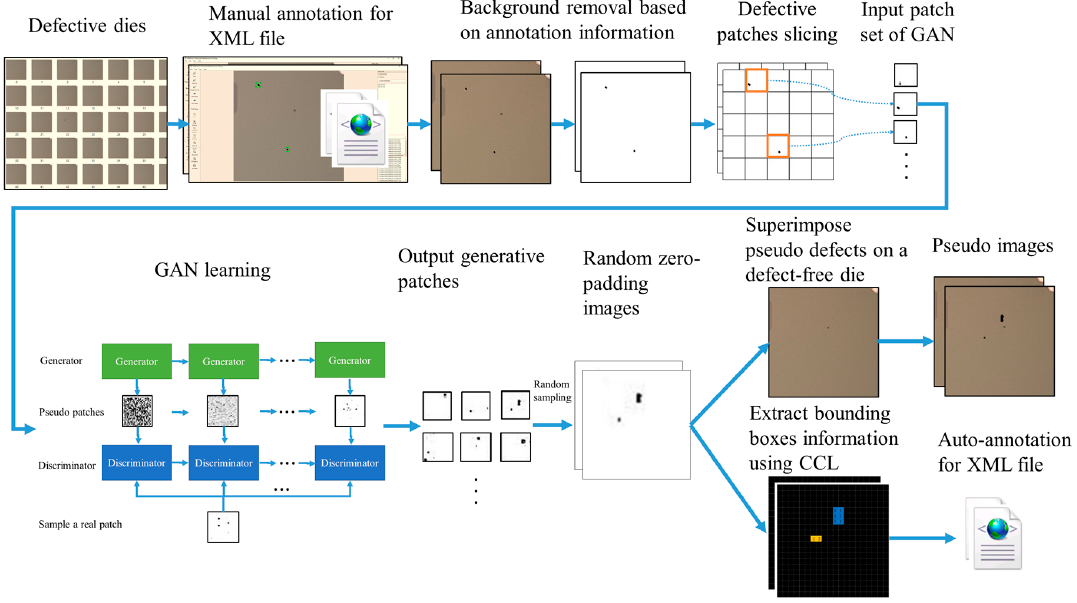
Figure 3. The flowchart of GAN-based data argumentation and